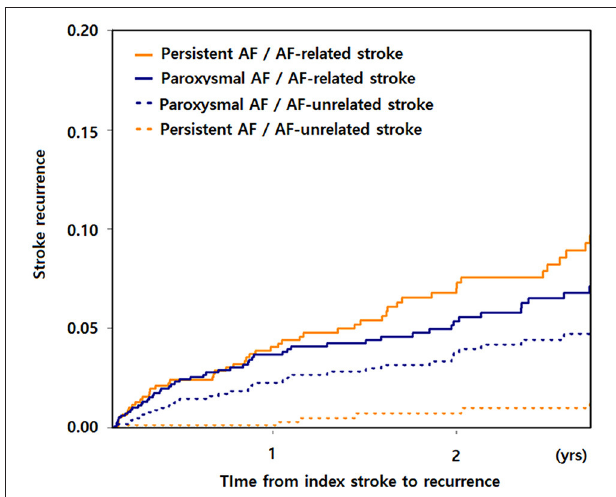
FIGURE 2 | AF-related and AF-unrelated stroke recurrence from index stroke according to the type of AF. AF, atrial fibrillation.